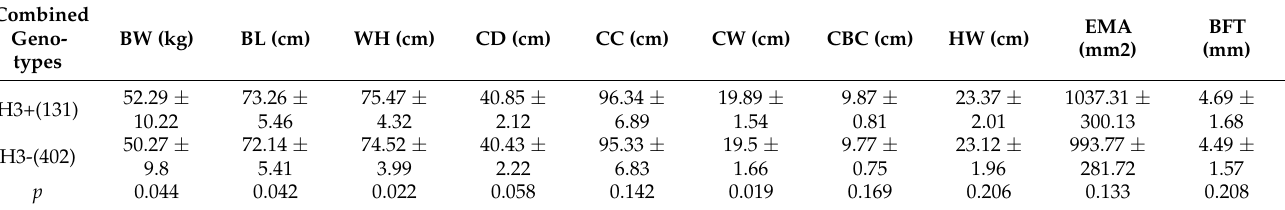
Table 6. The effect of haplotype H3 to the body measurements traits and ultrasound traits in GSTS